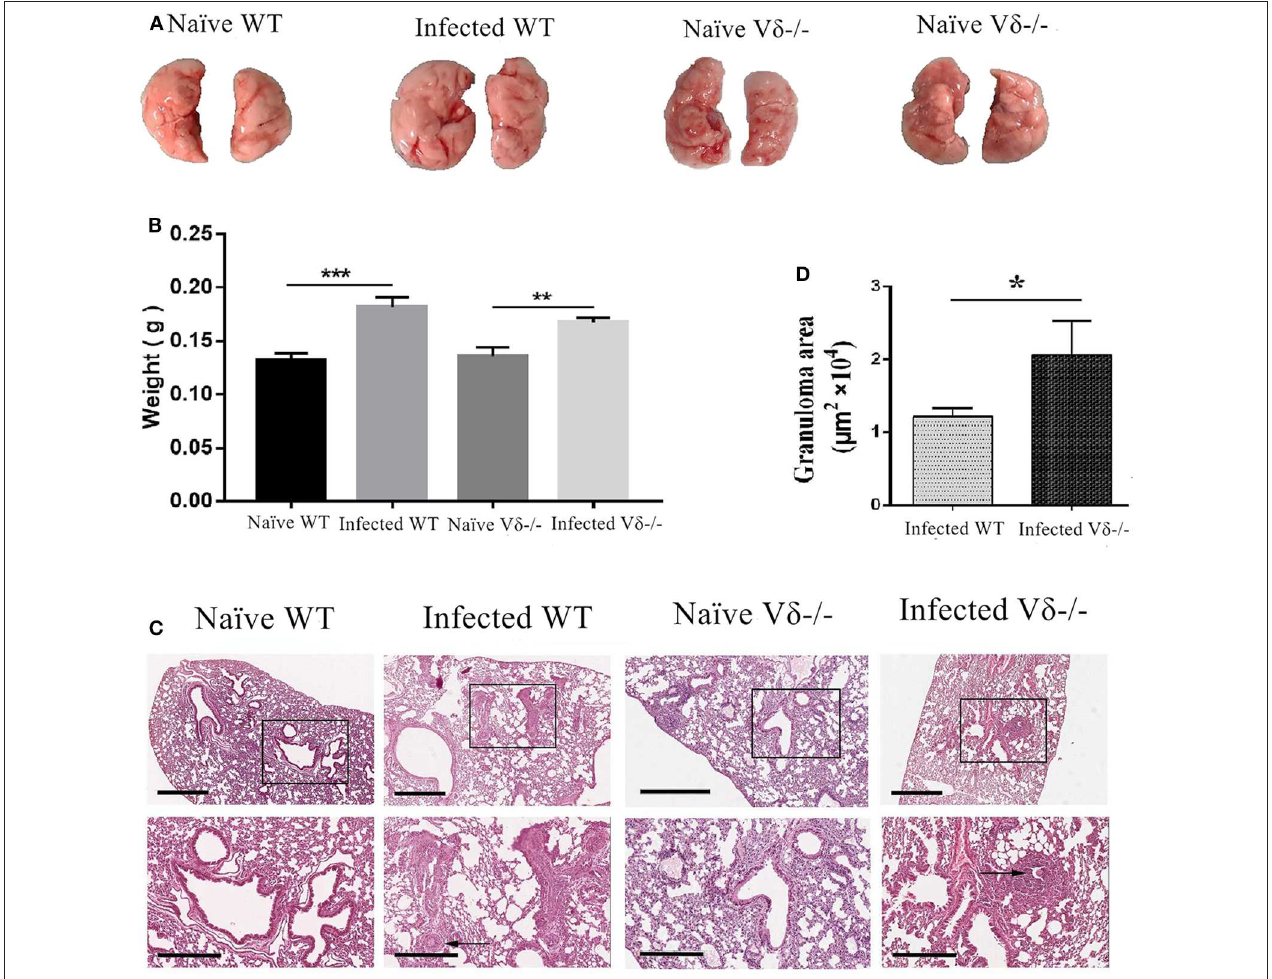
FIGURE 4 | Pathological changes in the lung of infected V δ − / − mice. C57BL/6 and V δ − / − mice were infected with 40 ± 5 S. japonicum cercariae per mouse. Five to six weeks after infection, mice were euthanized. (A) Lung appearance in naïve and infected WT and V δ − / − mice was compared. (B) The weight of the lung from naïve and infected WT and V δ − / − mice was compared. (C) Hematoxylin and eosin staining were performed on paraffin sections of lung tissue. Scale bar, 600 µ m (upper), 300 µ m (lower). (D) The area of granuloma in infected WT and V δ − / − mice was compared. A representative of three independent experiments with 5–6 mice per group is shown. The error bars are SD, * P < 0.05, ** P < 0.01, *** P <